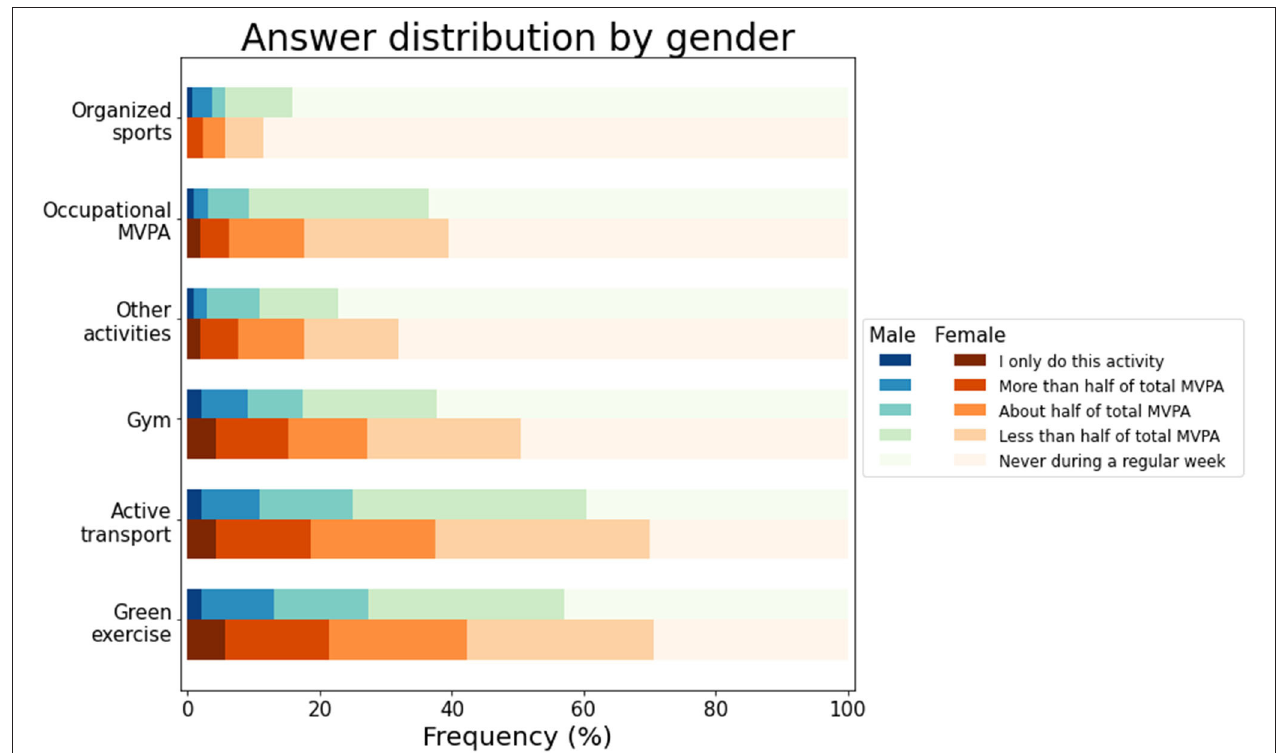
FIGURE 1 | Prevalence of male and female Italian immigrants in Norway engaging in different modes of MVPA during a regular week relative to their total